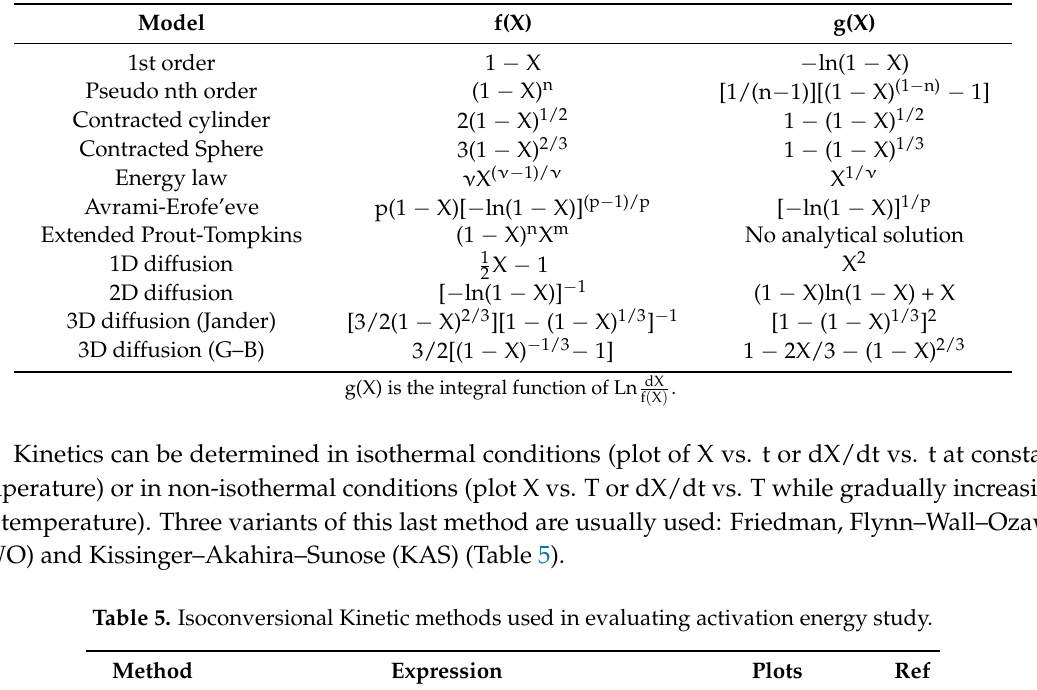
Table 4. Examples of kinetic models f(X) and their integral forms g(X).